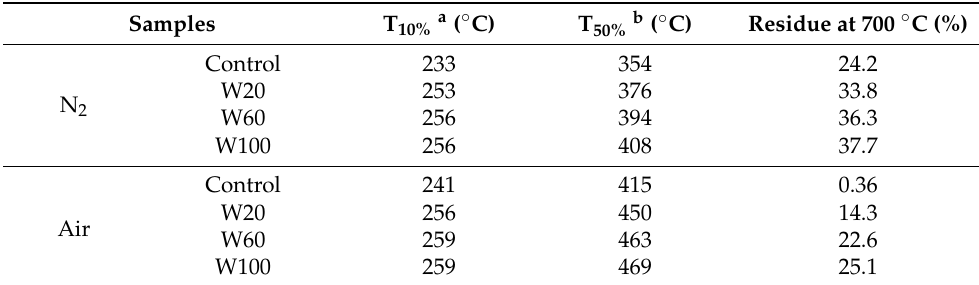
Figure 5. TG curves of the wool fabrics before and after treatment with PBTCA under nitrogen ( a ) and air ( b ) ambiance.